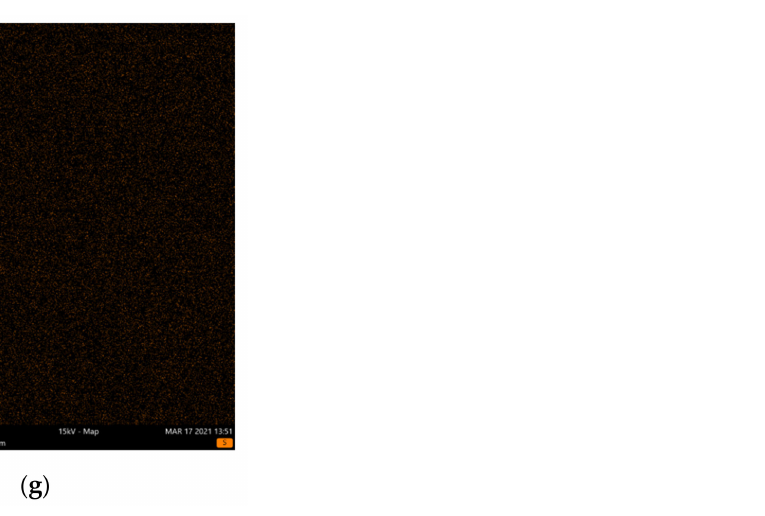
Figure 3. SEM image of the 45Si2P5S glass sample (backscattered electrons: BSEs) ( a ) and associated EDS elemental maps for ( b ) O, ( c ) Si, ( d ) P, ( e ) K, ( f ) Mg, and ( g ) S.